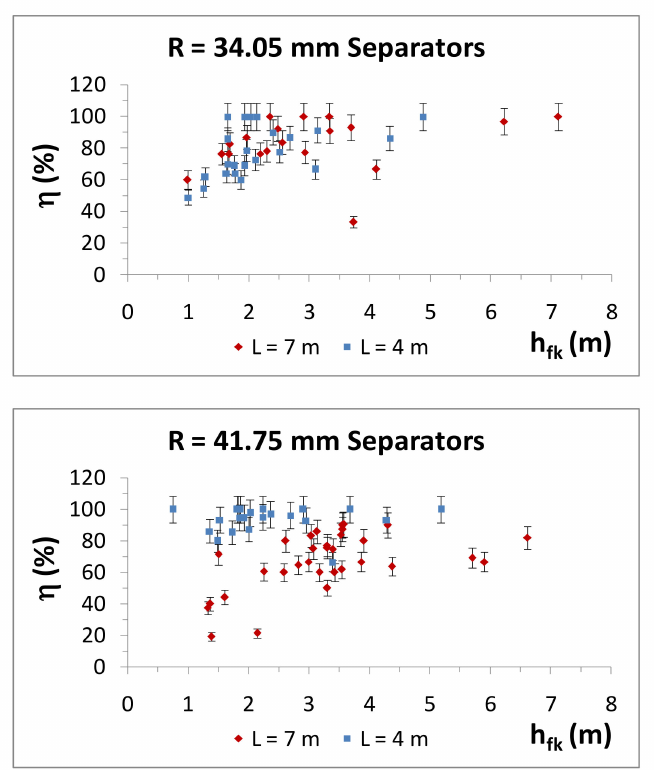
Figure 14. Relationship between h fk (m) and η (%) for the separators tested with different helix radiuses R (34.05 mm and 41.75 mm) and tube lengths L (4 and 7